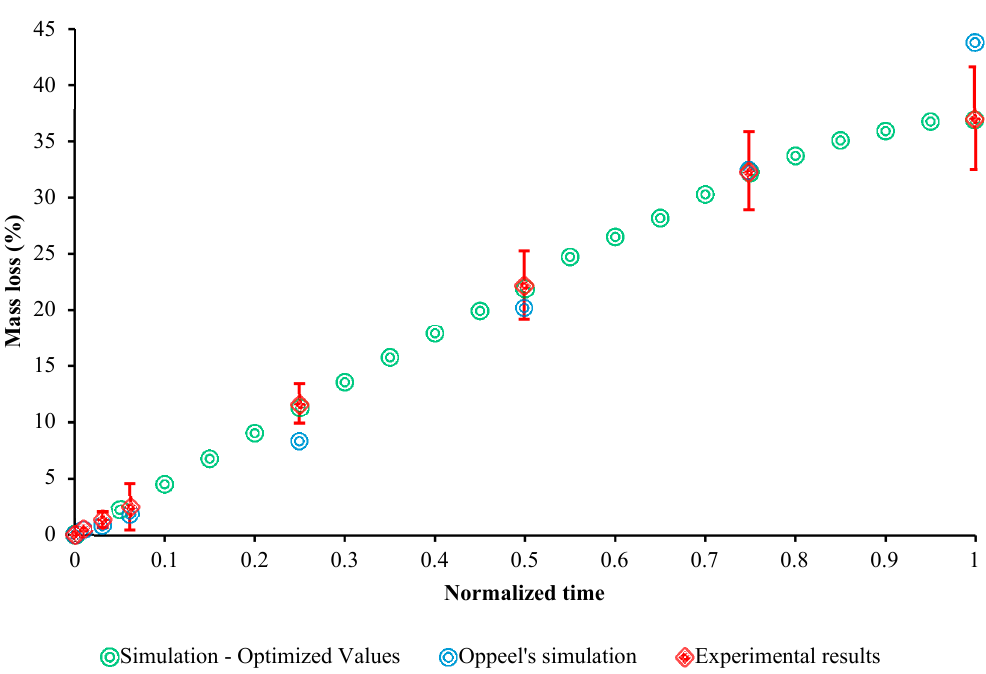
Figure 10. Experimental (n = 3) and FE representation of the AZ31 alloy using the developed model versus Oppeel et al [26] . (Immersion testing).